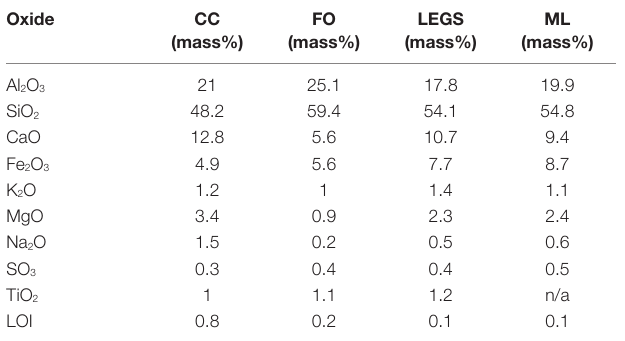
TaBle 1 | Oxide analysis (mass%) provided by manufacturer, based on a single analysis.